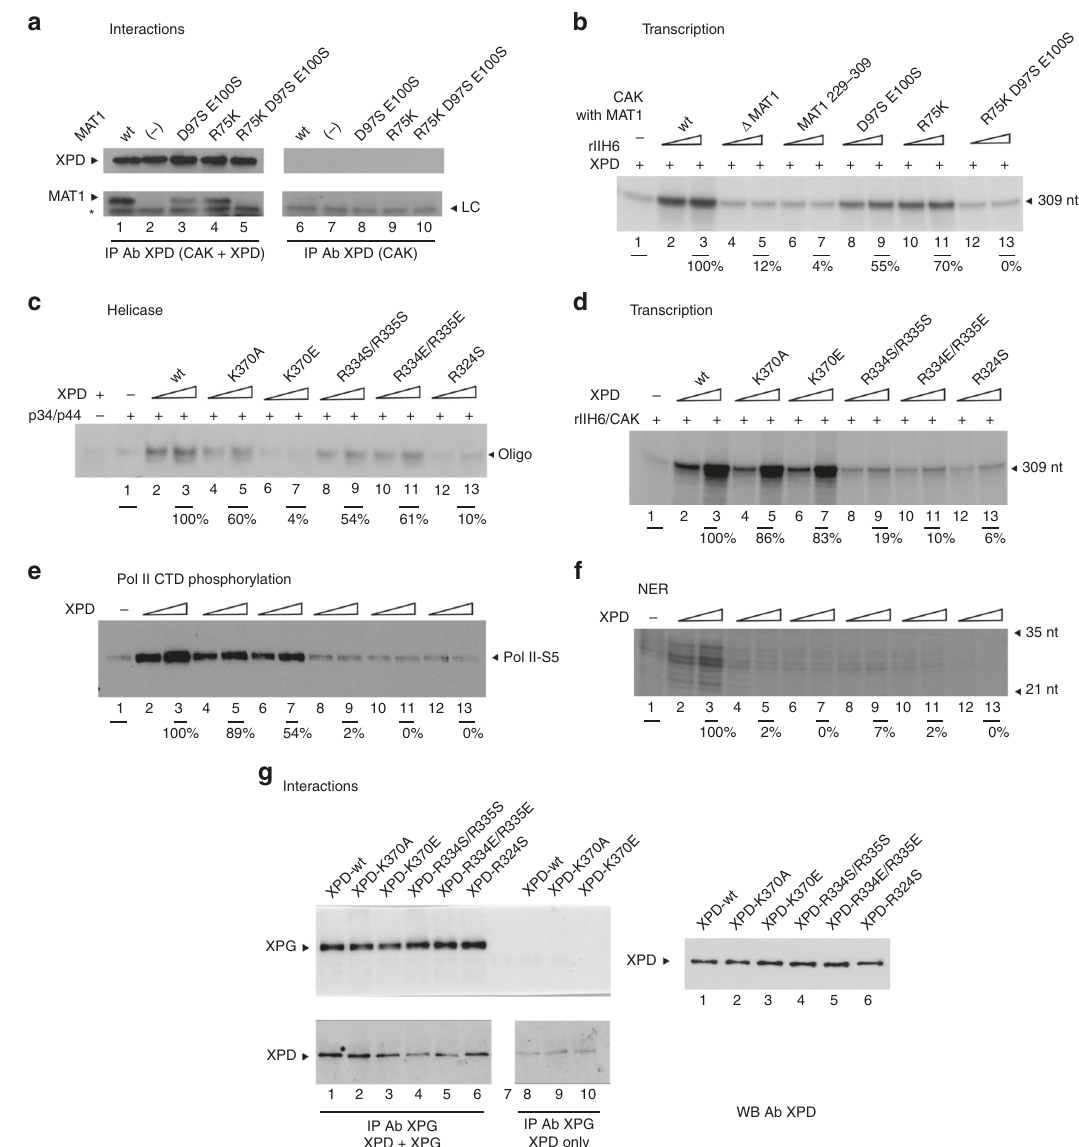
Fig. 5 Functional analysis of human XPD and MAT1 variants. a XPD/CAK interactions analyzed using a pull-down assay with immobilized XPD (Lanes 1 – 5). Control extract (for details see Method section; lanes 6 – 10). MAT1 and XPD were detected using speci fi c antibodies. The asterisk marks the light chain of the antibody (LC). b In vitro transcription activity assay of wild-type MAT1 and its variants. Puri fi ed CAK lacking MAT1 ( Δ MAT1) or containing its variants (100 and 250ng) were added to a reconstituted system containing core-TFIIH lacking XPD (rIIH6) (250 ng) and XPD (200 ng). Transcripts were analyzed by electrophoresis followed by autoradiography (309 nt run-off transcript) and was normalized to that of wild-type CAK/MAT1. Numbers correspond to the average values obtained for the two quantities of CAK tested. c XPD Helicase assay. Increasing amounts of XPD wild type and variants (100 and 200 ng) were added to a 5 ′ -strand extension probe (for details see Method section; lanes 2 – 13). Controls were performed in absence of p34/p44 or XPD as indicated. The reaction was analyzed by electrophoresis followed by autoradiography and helicase activity (unwound oligonucleotide, black arrow) was normalized to that of wild-type XPD. The average activity estimated from three independent experiments ( n = 3, mean, ±sd) using the highest XPD concentration is indicated in Table 3, whereas the panel shows a representative experiment. d In vitro transcription activities of reconstituted TFIIH containing XPD variants (see Methods section for details). The size of the transcript is indicated by the black arrow and the transcription activity estimated using the highest XPD concentration is indicated below the autoradiography. The average activity estimated from four independent experiments (two independent sets of reactions performed with the two XPD concentrations, n = 4, mean ± sd) is indicated in Table 3, whereas the panel shows a representative experiment. Lane labels of c and d apply also to e and f , respectively. e Phosphorylation activities of the TFIIH complexes analyzed by immunoblotting using an antibody directed against the phosphorylated form of serine 5 from the CTD heptad repeat. f In vitro NER activity of reconstituted TFIIH containing XPD variants. XPD wild type or variants (100 and 200 ng, see Method section for details). The NER product is visible between the 35 and 21 nt limits. g Pull-down assay with XPG and wild-type XPD as well as XPD variants. Lanes 1 – 6 present the pulldown experiments where XPG was immobilized with an anti-XPG antibody. For control experiments an extract expressing the DsRed protein instead of human XPG was used (lanes 8 – 10). XPD and XPG were detected by Western Blot using monoclonal antibodies. The XPD loading controls of lanes 1 – 6 are shown on the right side of the